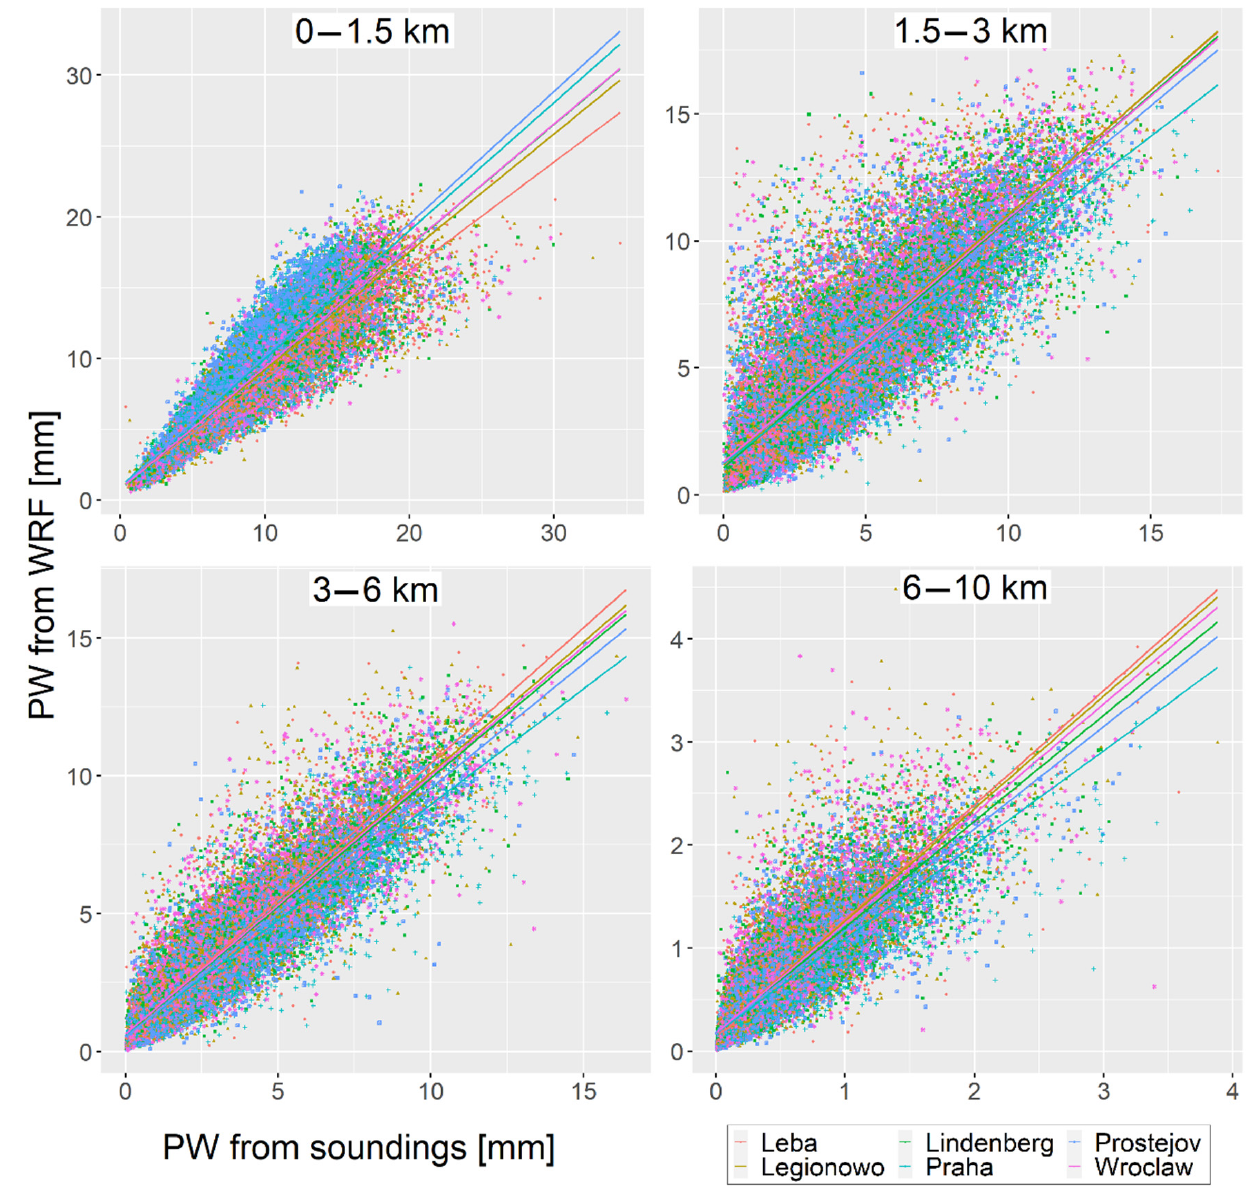
Figure 4. Comparison of PW data from WRF model and data from atmospheric soundings between 2001 and 2010 at individual levels: below 1.5 km, 1.5–3 km, 3–6 km and 6–10 km. The annual courses of PW standard deviation from soundings and from the WRF model are very close at the tropospheric levels from 1.5 km to 6 km (Figure 3). At the level up to 1.5 km, the standard deviation from the WRF data is a smaller than from soundings, whereas at the highest part of troposphere above 6 km, it is larger. The values of SD from the WRF model at the level of 6 to 10 km for winter months are almost the same as the monthly means of PW from soundings (Table